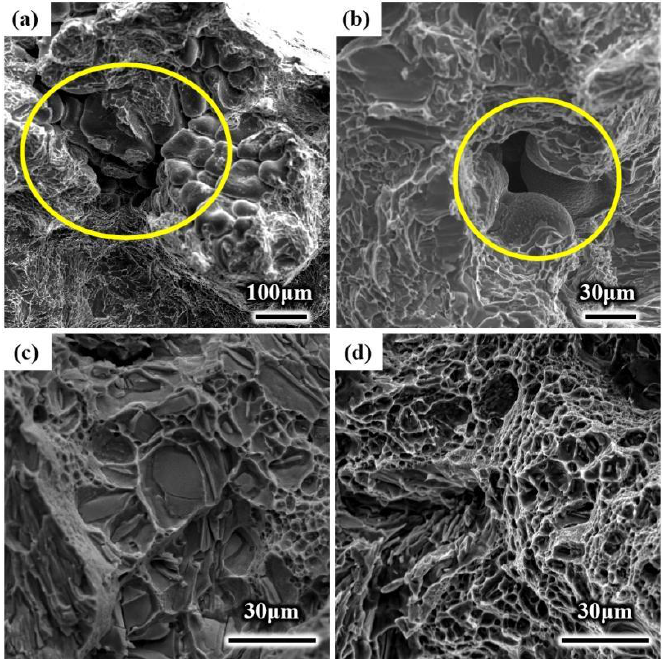
Figure 7. Fracture morphology of ( a , c ) conventional ingot and ( b , d ) ultrasonic ingot.